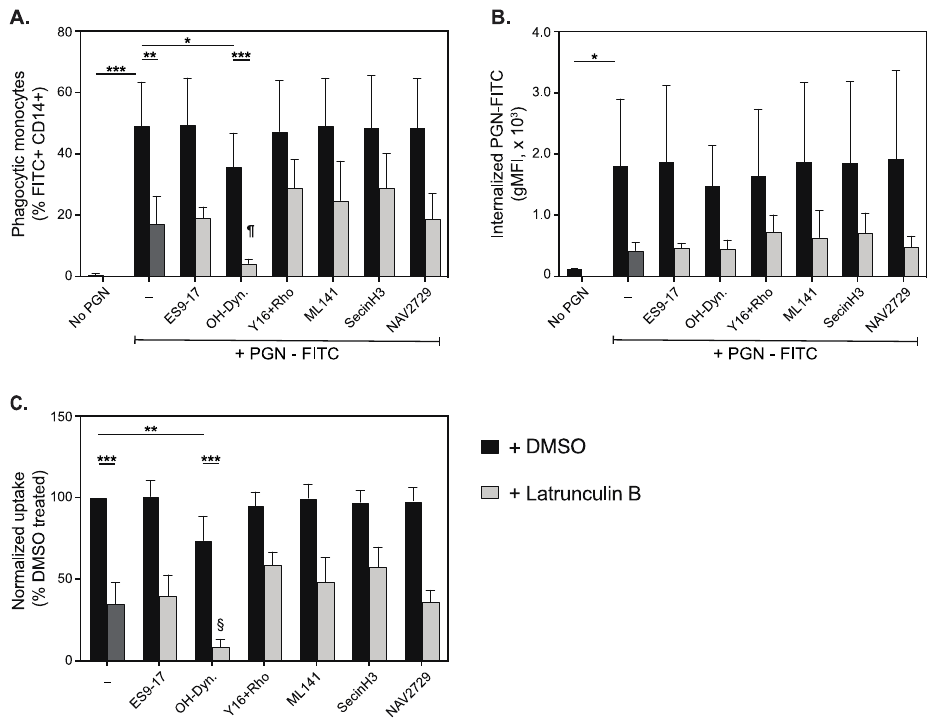
Figure 4. Actin-independent internalization of PGN particles by primary human monocytes. Summary representation (mean ± SD, n = 8) of monocyte internalization of FITC labeled PGN in the presence of endocytic inhibitors, by themselves (black bars) or in combination with 20 µM latrunculin B (light grey bars). The single inhibition with latrunculin is depicted as a dark grey bar in the absence of additional inhibitors. Panels depict frequency of phagocytic monocytes after 30 min incubation with PGN-FITC particles at 37 °C ( A ), the adjusted fluorescence intensity of internalized particles (gMFI, ( B )) and the relative effect of inhibitors after pairwise normalization to uptake in mock (DMSO) treated cells ( C ). Statistically significant differences between relevant groups are depicted conventionally (* p < 0.05, ** p < 0.01, *** p < 0.001), except for panel ( A , C ), where ¶ ( p = 0.0363) and § ( p = 0.0074) depict significant changes when the combined latrunculin B and hydroxy-dynasore treatment is compared to latrunculin alone.